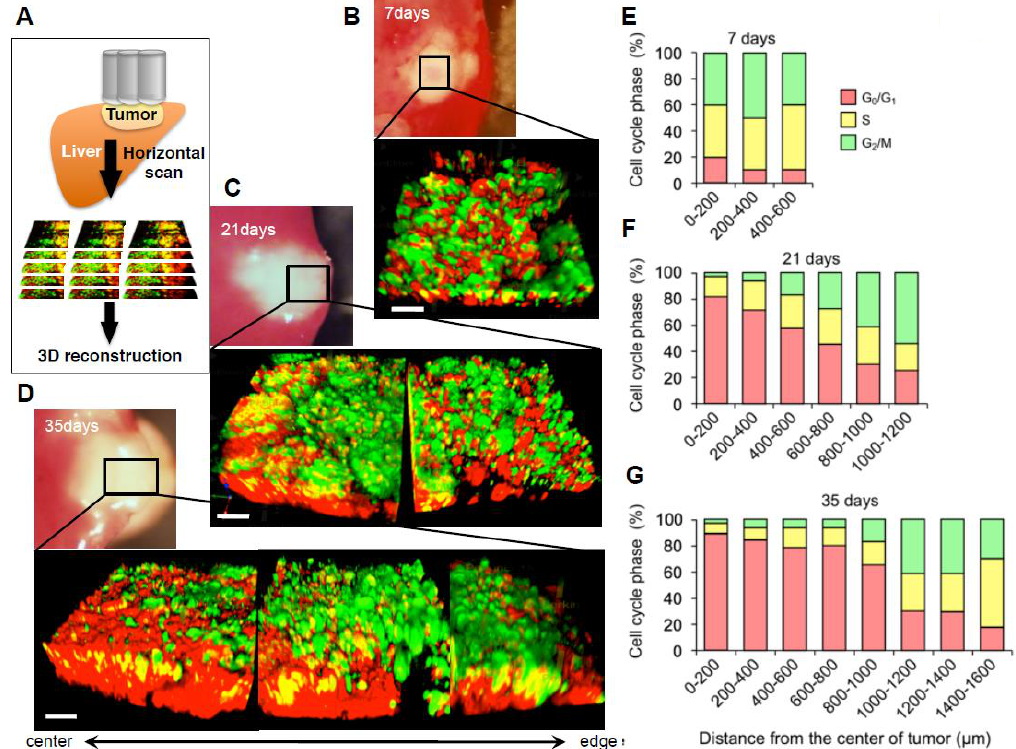
Figure 3. Three-dimensional image of FUCCI-expressing tumor reveals a vast majority of quiescent cancer cells. ( A ) Schematic diagram of in vivo CLSM imaging of different-sized tumors. Tumors were scanned from the center to the edge. 800 × 800 pixels and 1.0 μm z steps were scanned, which took 1–2 s per section, with 6–8 min per full 3D scan. The tracing data were imported to Velocity 6.0 version (Perkin Elmer), where all further analyses were performed, and then the scanned images were three-dimensionally reconstructed. ( B – D ) Representative 3D reconstruction images of a nascent tumor at 7 days after cancer-cell implantation ( B ), 21 days ( C ), and 35 days ( D ) after implantation. ( E – G ) Histograms show the distribution of FUCCI-expressing cells at different distances from the center. The number of cells in each cell-cycle phase was assessed by counting the number of cells of each color at the indicated time points. The percentage of cells in the G 2 /M, S, and G 0 /G 1 phases of the cell cycle is shown. Scale bars represent 100 μm. (Reproduced from [46] with the permission of Taylor and Francis).